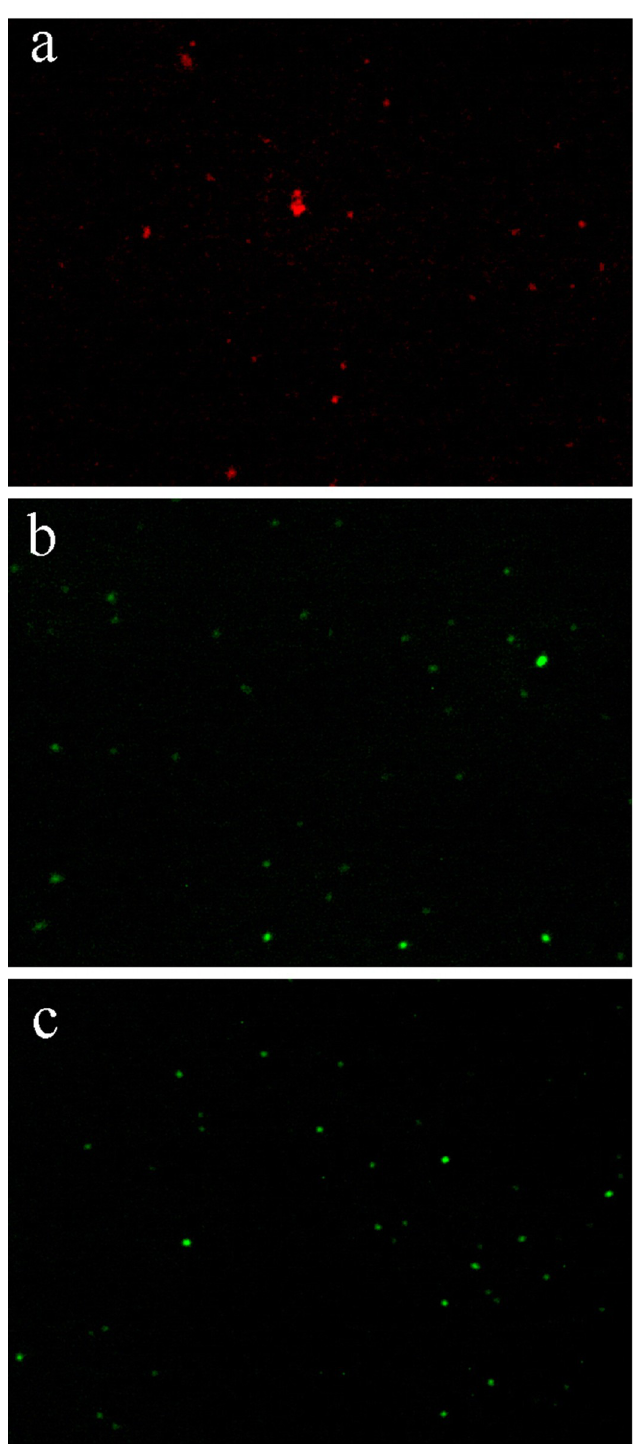
Fig 7. Fluorescence microscopy images of Pseudomonas aeruginosa . The P . aeruginosa were exposed to (a) protoporphyrin IX–ethylenediamine derivative (PPIX-ED)–mediated photodynamic antimicrobial chemotherapy (PACT), (b) PPIX-ED with no light (b), or (c) no treatment (control group).